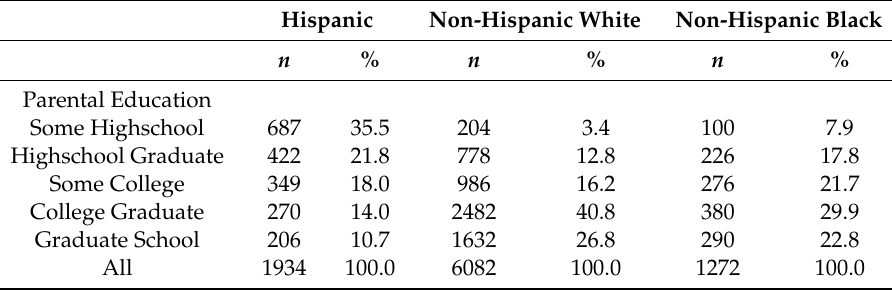
Table 2. Education level by ethnicity.